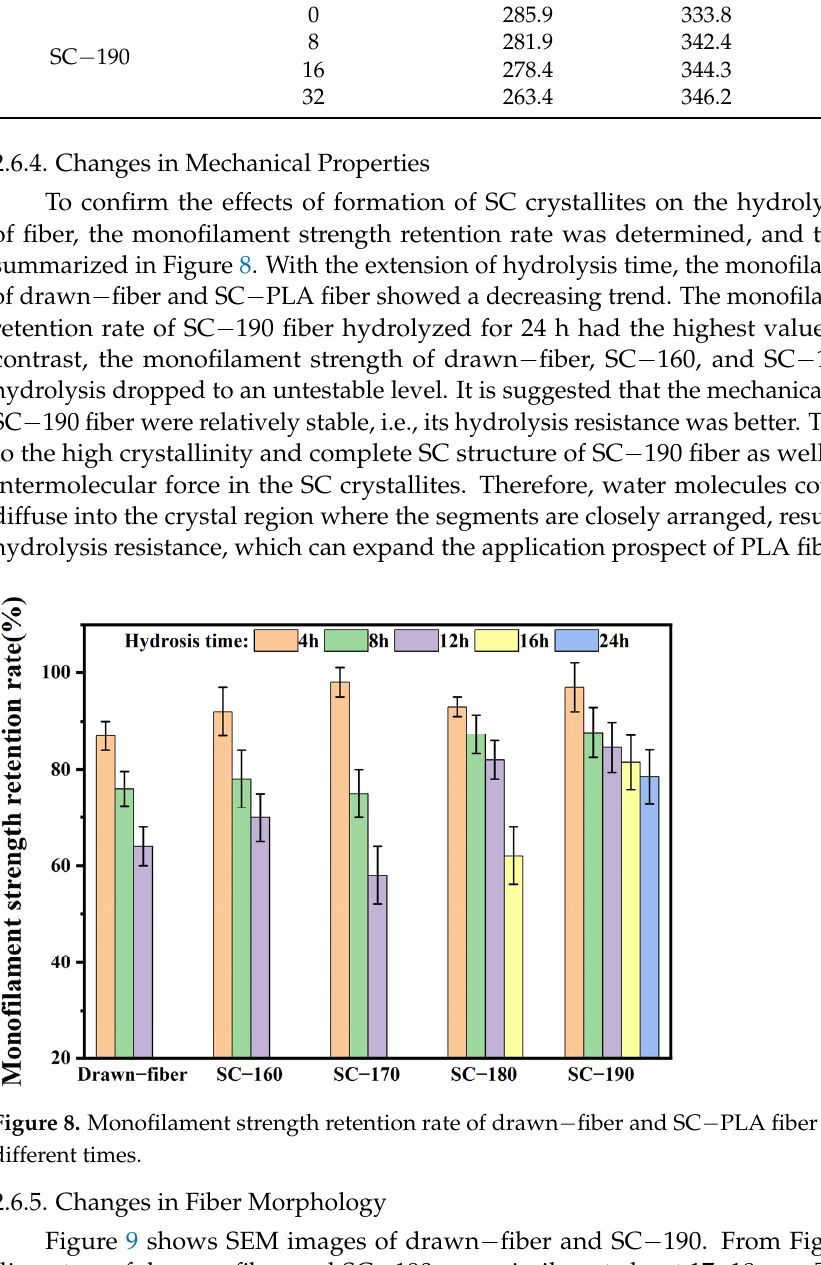
Table 7. Thermal decomposition temperature of drawn − fiber and SC − 190 fiber hydrolyzed for different times.